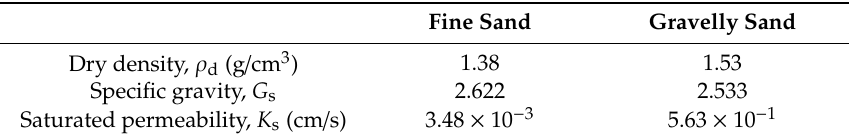
Table 1. Basic properties of materials used in the study.